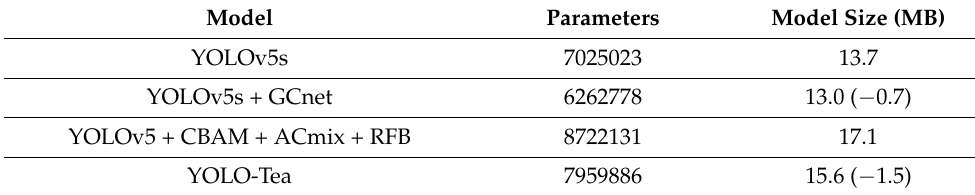
Table 7. The data of resource consumption experiment.